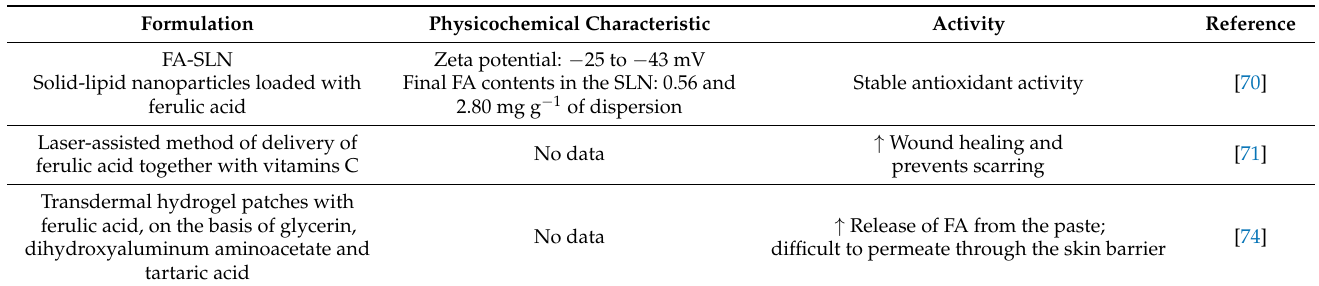
Table 1. The new formulations of ferulic